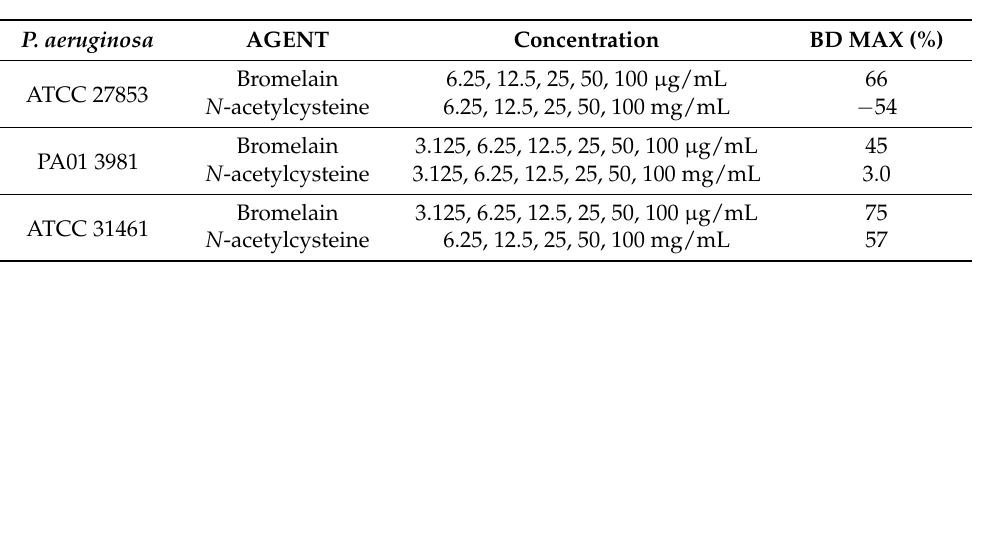
Table 1. The biofilm dissolution action of individual agents on the biofilm secreted by Pseu- the table. Note: 176 BD MAX (%): Maximum Biofilm Dissolution